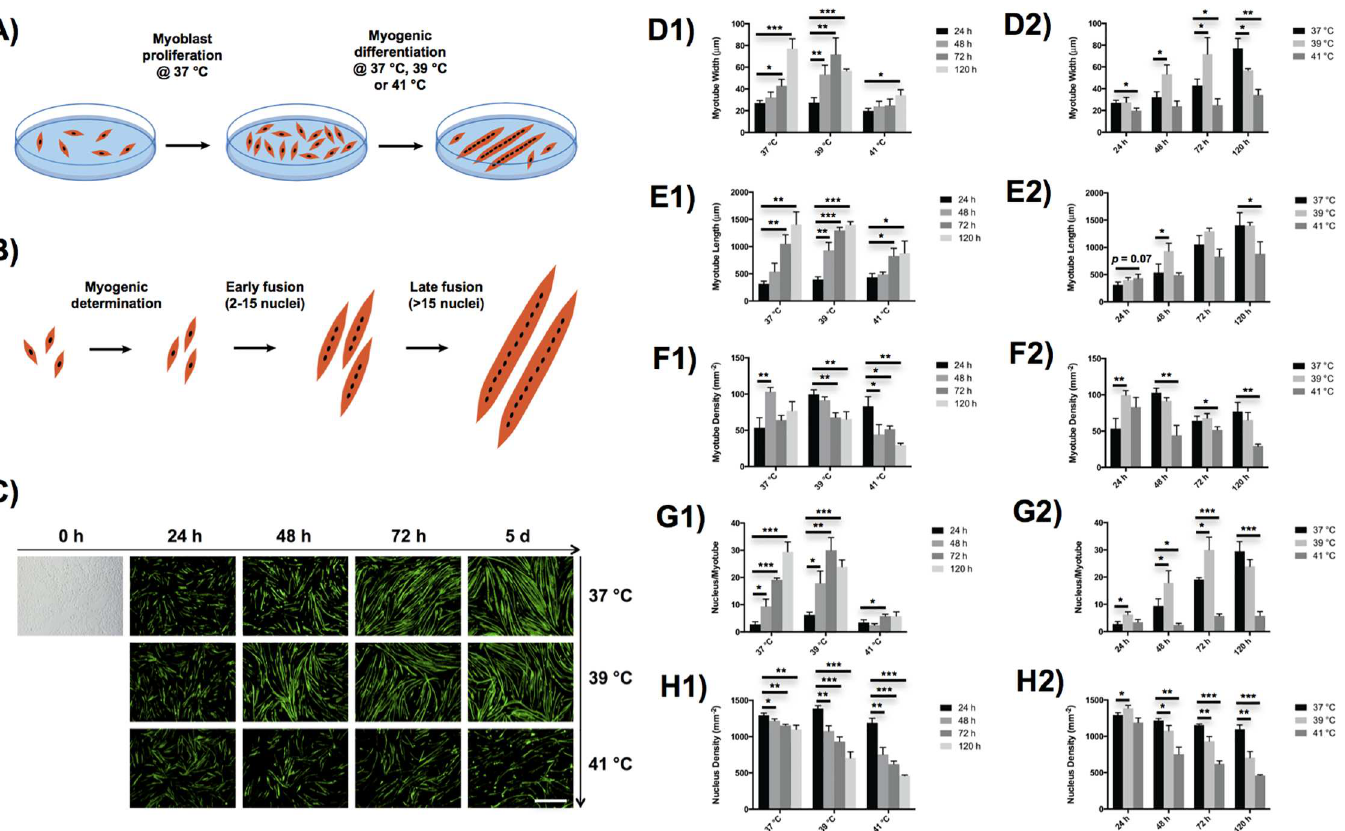
Fig 1. Effects of hyperthermia treatment on myotube morphology during myogenic differentiation of C2C12 myoblasts. Schematics of (A) hyperthermia performed on myogenicdifferentiation after myoblast proliferation, and (B) myoblasts undergoing three steps, i.e. myogenicdetermination, early fusion, and late fusion, during myogenicdifferentiation. (C) Characteristic microscopy images of myoblasts in bright field (0 h) and myosin heavy chain- positive myotubes (green). The myotube images were taken at four different time periods, i.e. 24 h, 48 h, 72 h, and 120 h, and three different temperatures, i.e. 37˚C, 39˚C, and 41˚C. Scale: 500 μ m. (D-H) Myotube morphologies, including myotube width (D), myotube length (E), myotube density (F), nucleus density per myotube (G), and overall nucleus density (H), were quantitatively analyzed.The error bars in (D-H) represent the standard deviationof the mean. Myotubes differentiated over 24 h were tested as a control in (D1, E1, F1, G1 and H1), and the myotubes cultured at 37˚C were used as a control in (D2, E2, F2, G2 and H2). All statistical differences against the controls are indicated. * p < 0.05, ** p < 0.01, *** p <